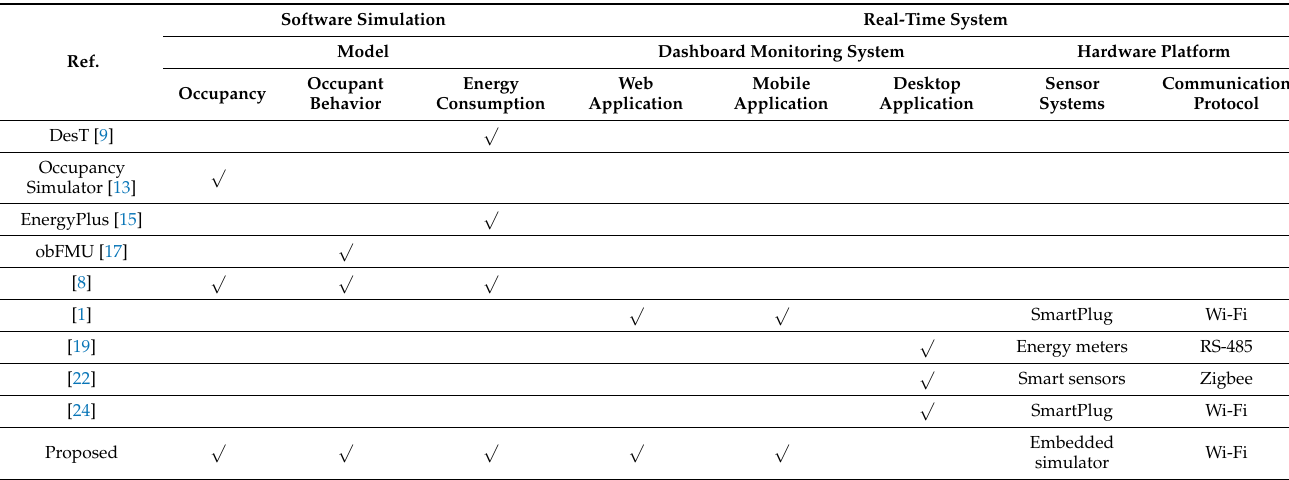
Table 1. Comparison between existing and proposed